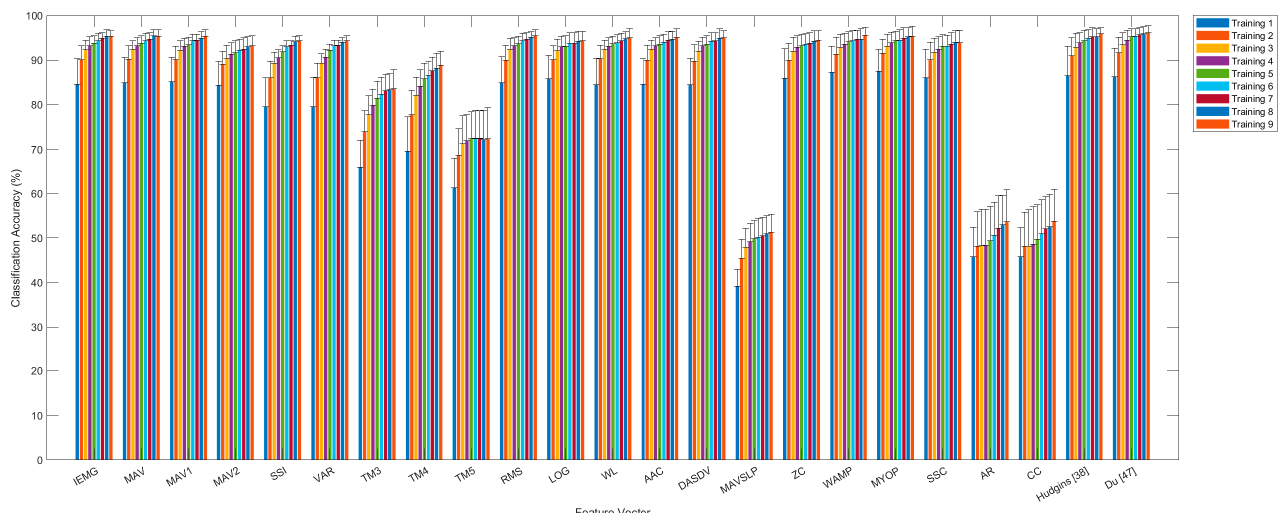
Figure 5. Classification accuracies of feature vectors and feature combinations according to training in Group 1.